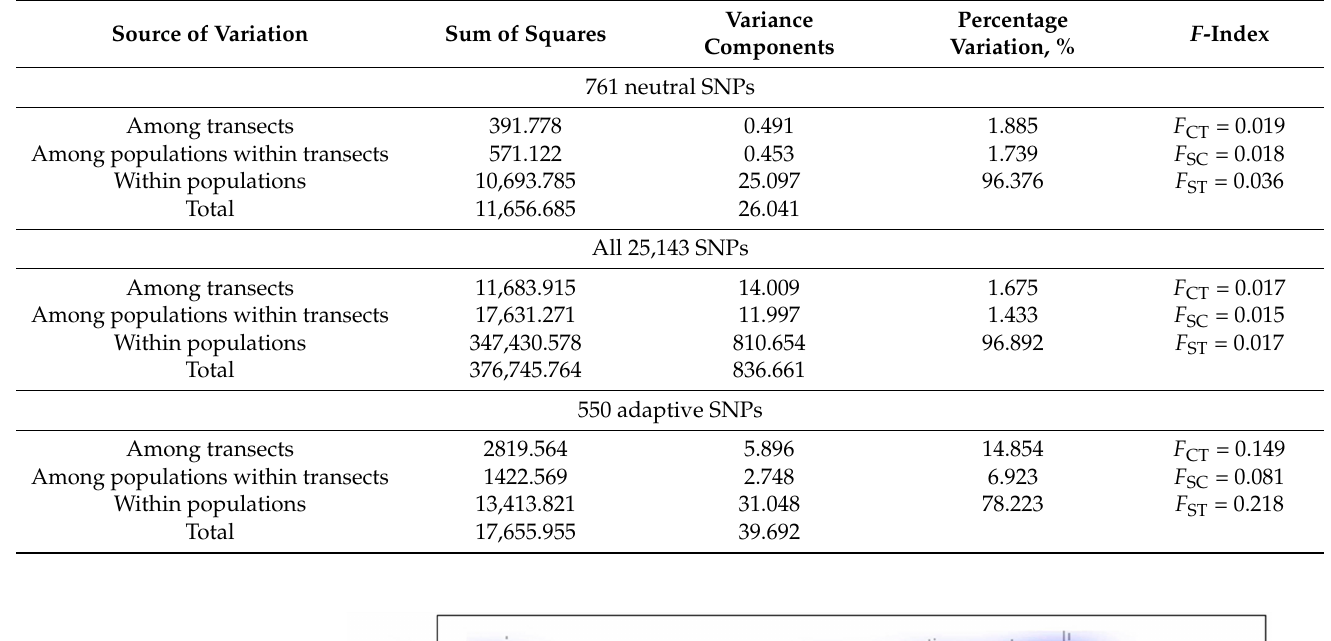
Table 4. AMOVA results for three different SNP datasets.